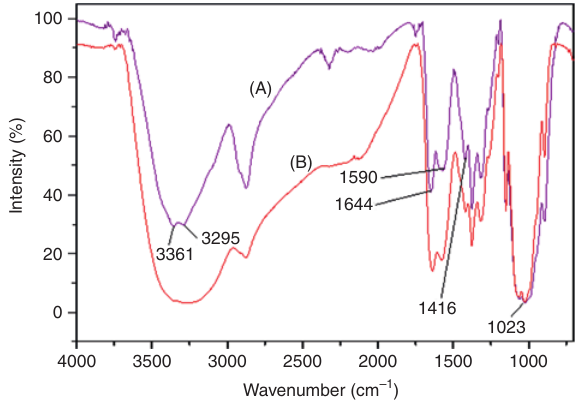
Figure 3: Fourier transformer infrared (FTIR) spectra of (A) pure chitosan and (B) chitosan capped silver selenide nanoparticles.